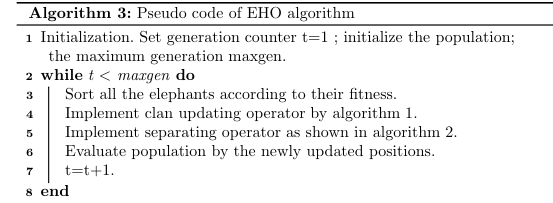
Algorithm 2: Pseudo code of separating operator